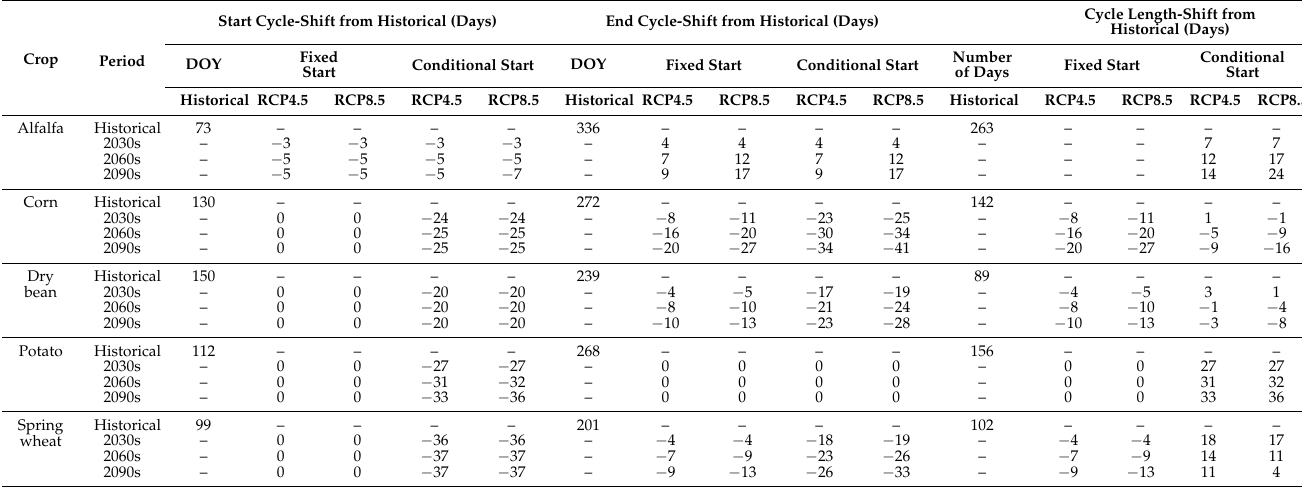
Table 4. Start, end, and length of the cycle ( ± number of days) with respect to historical planting dates (DOY) for alfalfa, corn, dry bean, potato, and spring wheat for future periods under two RCP